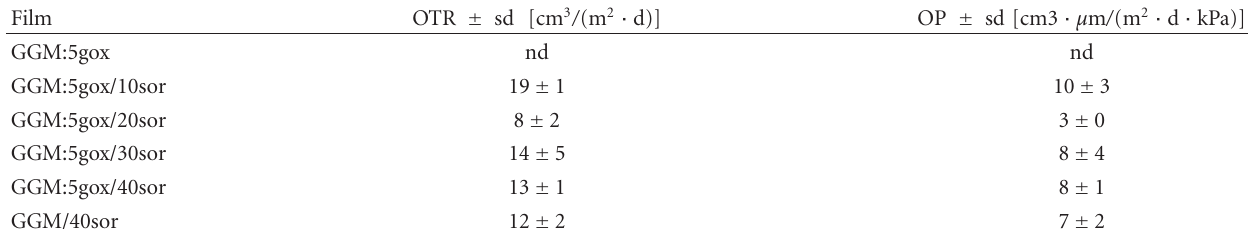
Table 4: Oxygen transmission rate (OTR) and oxygen permeability (OP) of films (mean ± standard deviations). Sample coding as presented in Table